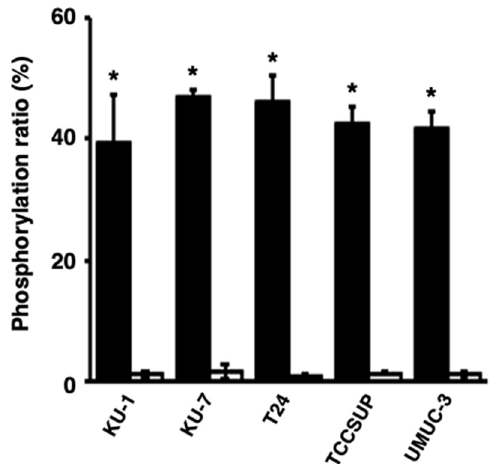
Figure 3. Release of activated PKC α from human bladder cancer cells. The phosphorylation ratios of the phosphorylation of a PKC α -specific peptide by the medium of bladder cancer cells after a 24 h culture (black bars) or medium only (white bars) were calculated. * p < 0.01, versus medium only.